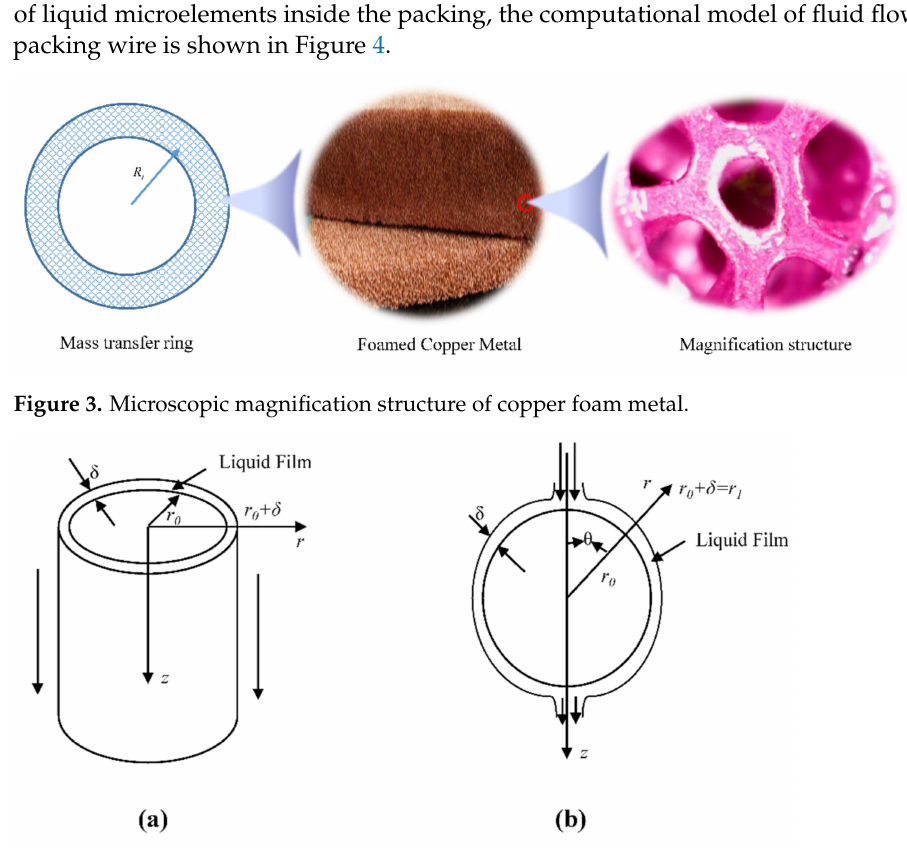
Figure 4. Calculation diagram of the liquid axial descending film ( a ) and circumferential flow around the flow ( b